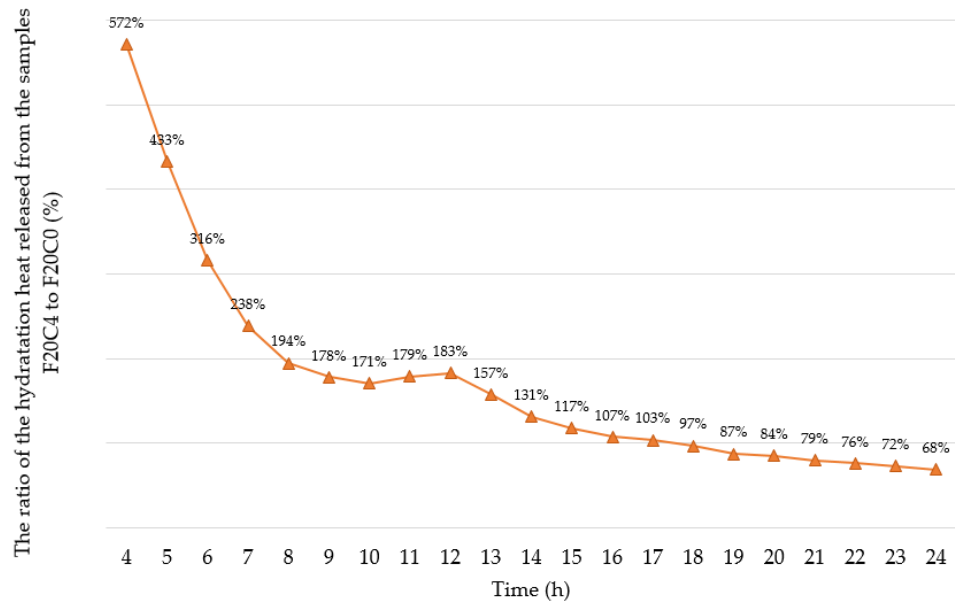
Figure 8. Increase in the amount of heat released from the NA modified paste compared to the reference one.